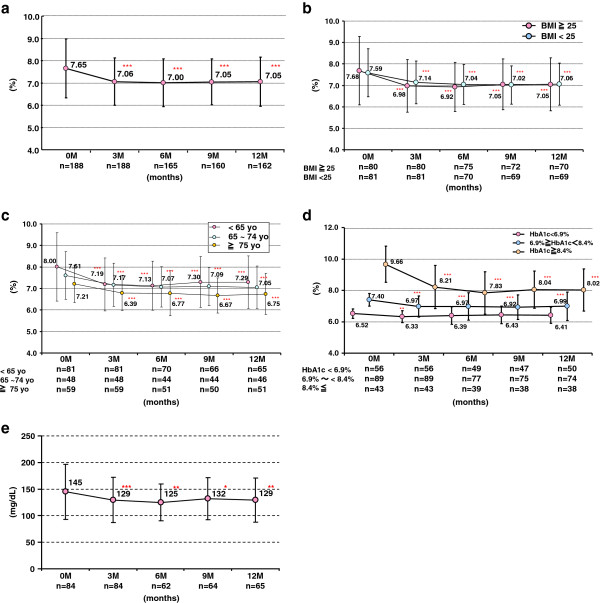
Serial HbA1c changes in (a) all subjects, (b) BMI-based groups, (c) age-based groups, (d) HbA1c-based groups, and (e) fasting plasma glucose. HbA1c, hemoglobin A1c; BMI, body mass index. *p < 0.05, **p < 0.01, ***p < 0.001, vs. baseline by paired t-test.